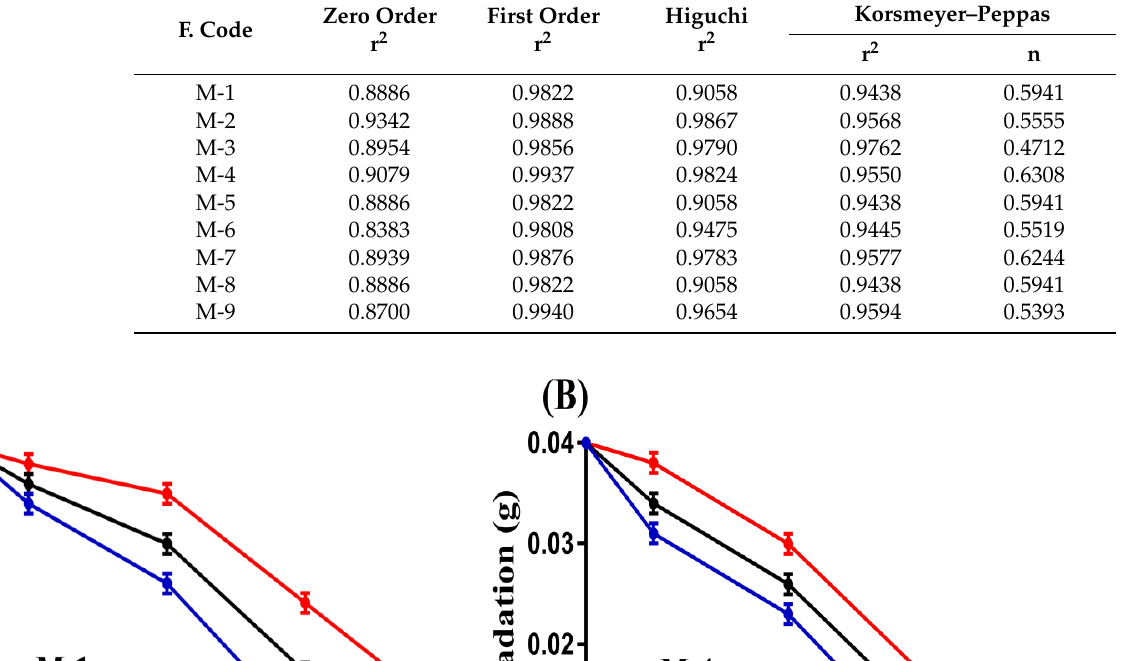
Table 4. Kinetic modeling release of Kt from CS/Al-g-pAa hydrogels.